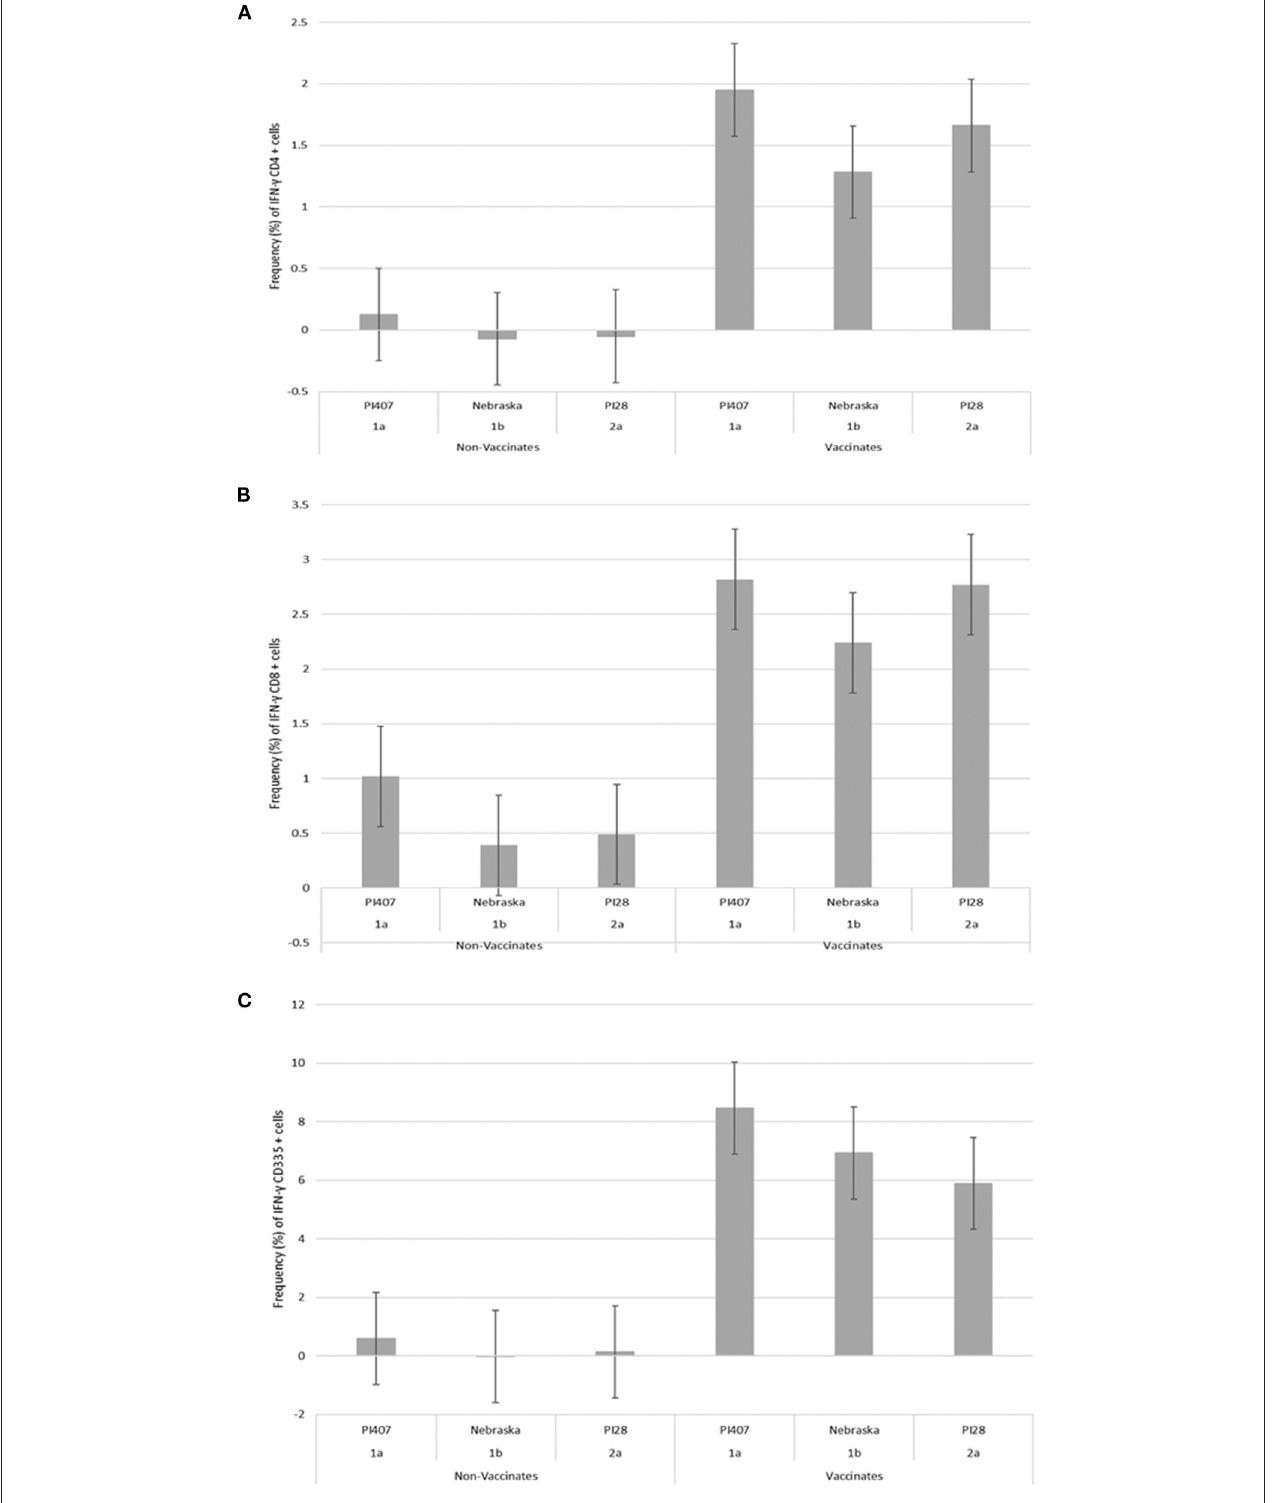
FIGURE 2 | Percent positive cells for each respective PBMC subset (A) CD4 + , (B) CD8 + , (C) CD335 + for IFN- γ mRNA expression in Group 1 vaccinated and non-vaccinated calves at ∼ 10–11 months post-initial vaccination and stimulated with three different BVDV strains (PI407 BVDV-1a, Nebraska BVDV-1b, and PI28